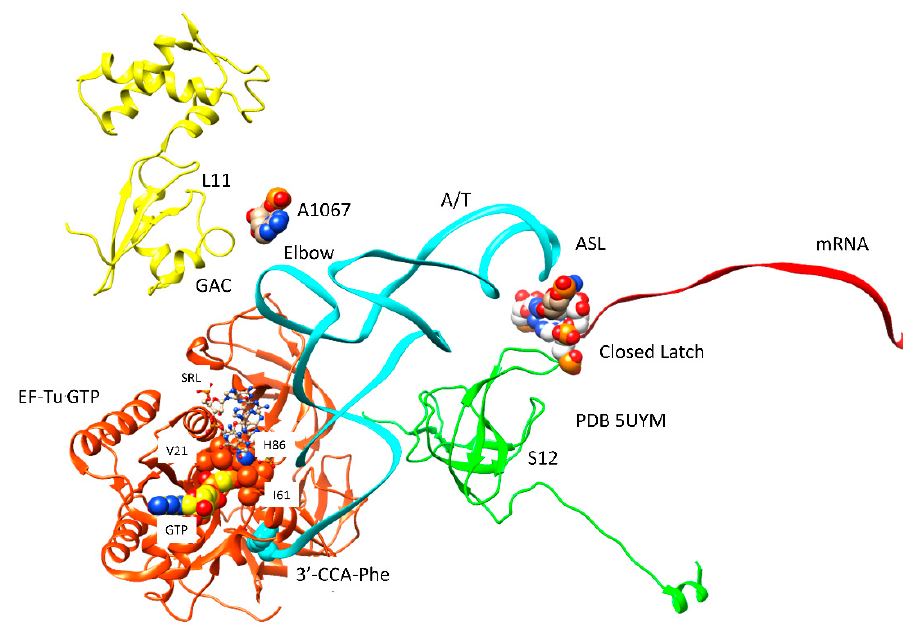
Figure 6. 50S GTPase-associated complex (GAC) and SRL (ball and stick representation) binding to aa-tRNA · EF-Tu · GTP activates His86 to stimulate GTPase activity. Numbering of EF-Tu residues is as in Figure 4.